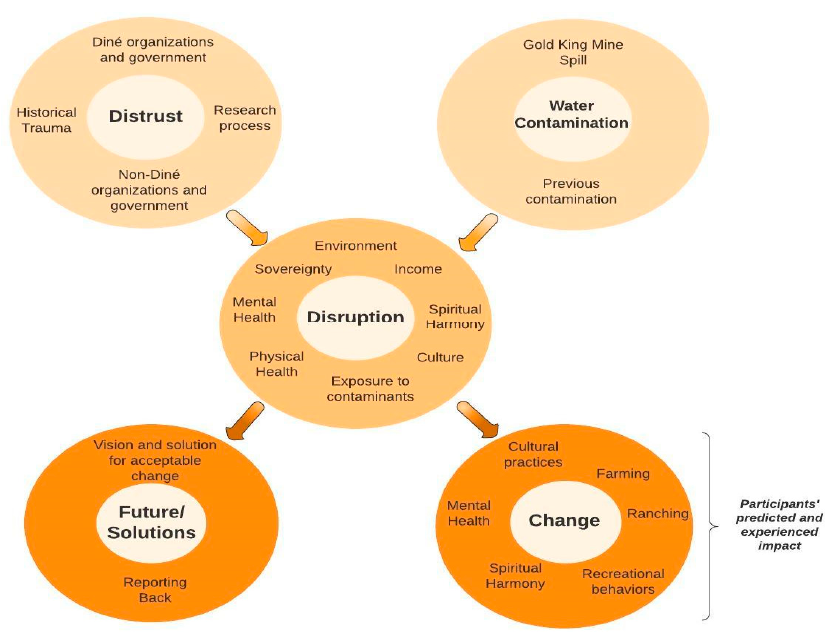
Figure 4. Combined impact of the Gold King Mine Spill water contamination and distrust contributing to risk of disruption and ensuing change and solutions.